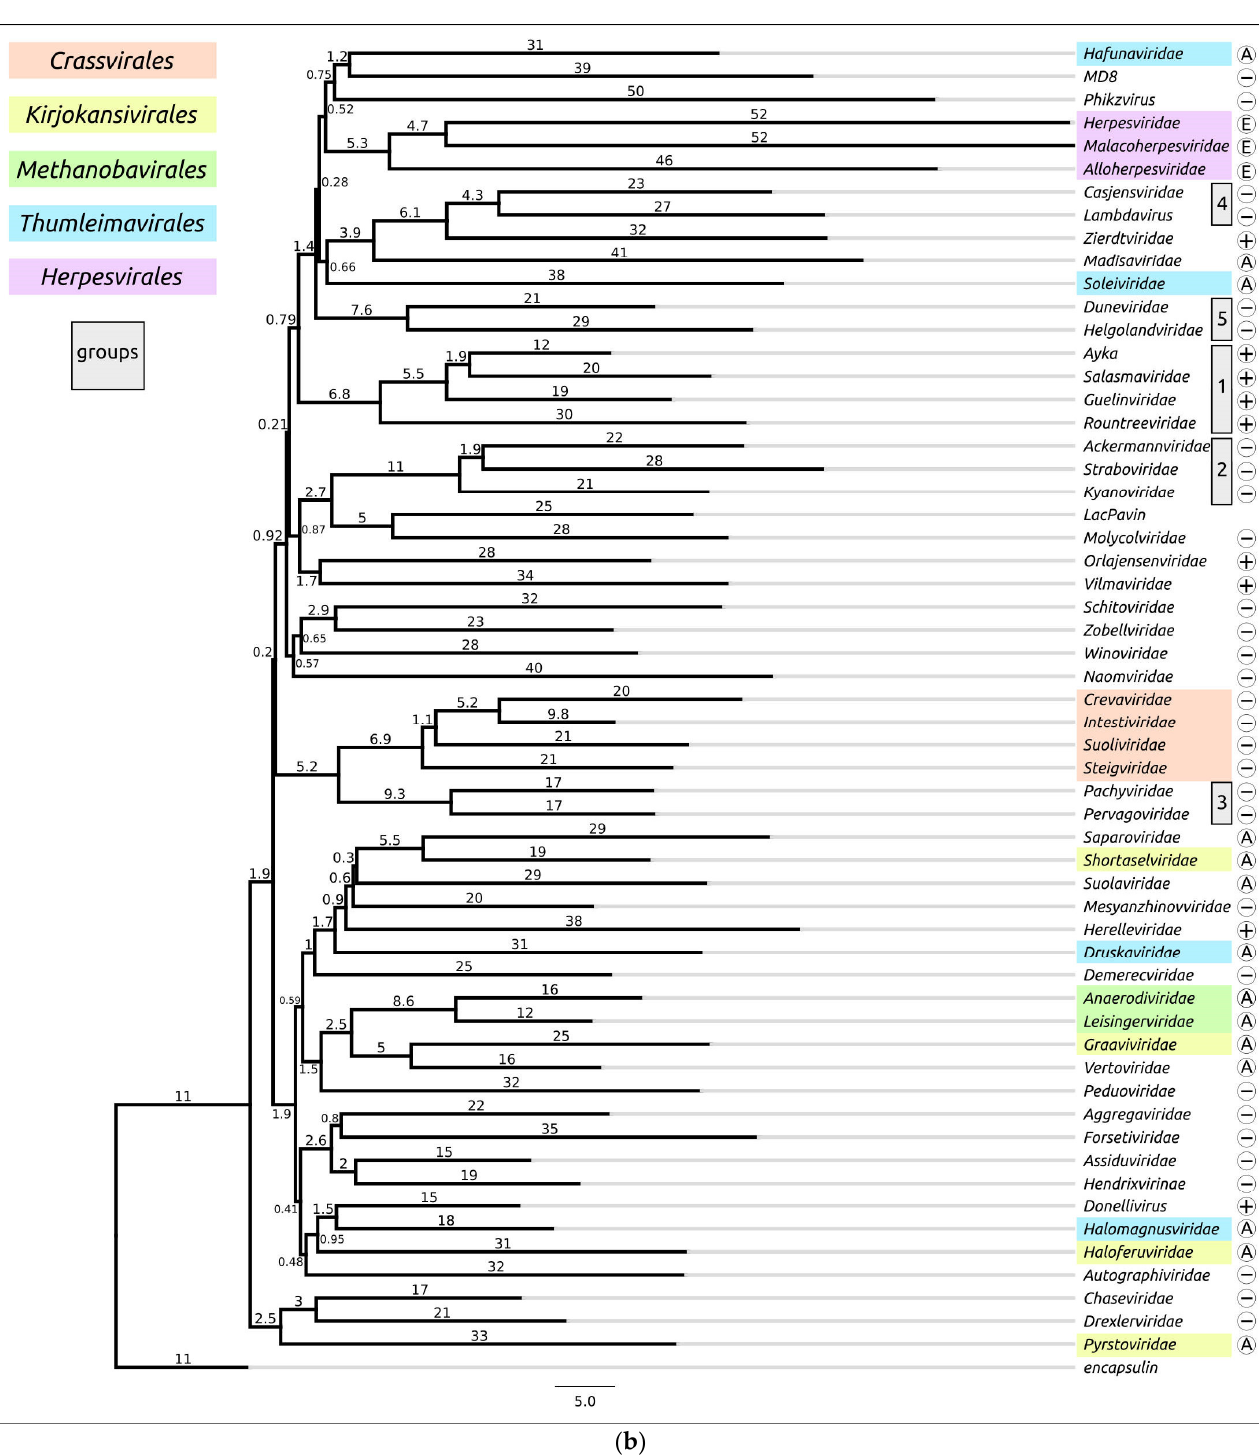
Figure 7. Matrix ( a ) and dendrogram ( b ) based on the pairwise Z-score comparisons of 57 major capsid proteins and encapsulin AF models, using DALI. The branch lengths are measured using the DALI Z-score and the tree was rooted to encapsulin. “A”—archaeal viruses, “E”—eukaryotic viruses, “+”—phages infecting Gram-positive bacteria, and “-”—phages infecting Gram-negative bacteria. Some of these observations can be biologically meaningful, reflecting the common origin and lifestyle of viruses. Group 1 comprises the so-called “ φ 29-like” lytic phages with a podoviral morphology and similar genome size of about 16–20 kb, infecting